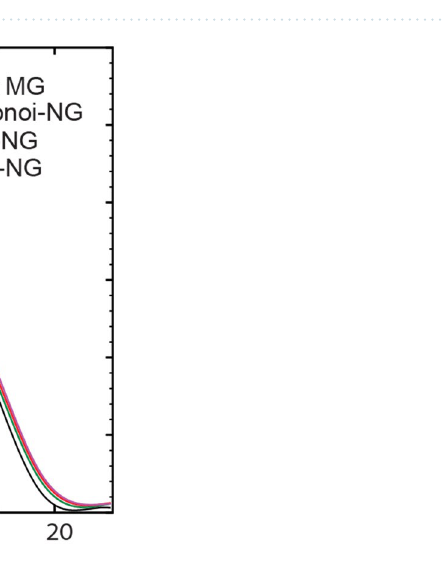
Figure 4. Spatial distribution of excess free volume in the Voronoi-NG model as compared to FCC-NG models based on MG carved particles (MG-NG) and inert gas condensation generated particles (IGC-NG). ( a )–( c ) Distribution of atomic volume averaged in a spherical volume of 1 nm radius around each atom, normalized by the bulk MG averaged atomic volume. ( d )–( f ) Distribution of atoms with normalized atomic volume greater than 1.03. Images ( d )–( f ) created with OVITO version 3.5.3, https:// www. ovito. org.